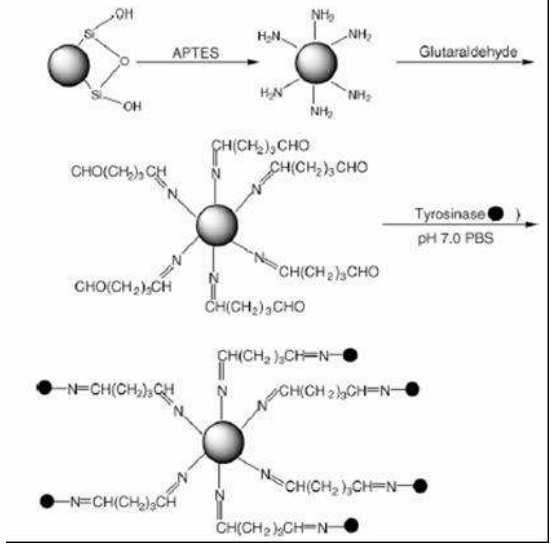
Figure 16. Preparation of magnetic bio-particles for a tyrosinase based biosensor ( Reprinted from [3] with permission from Elsevier